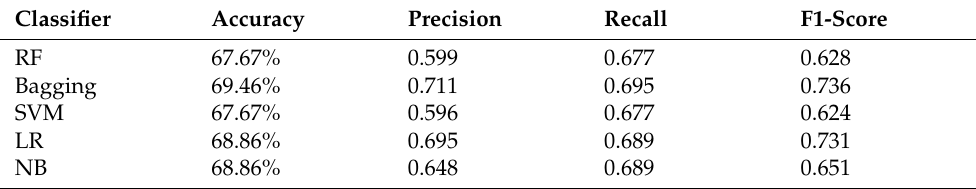
Table 20. Experiments with ML models and the MPQA lexicon on the TextBlob sentiments.